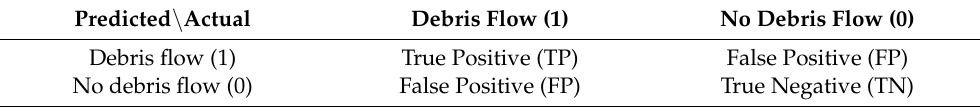
Table 5. The confusion matrix of debris-flow occurrence based on the vibration signal labeling.